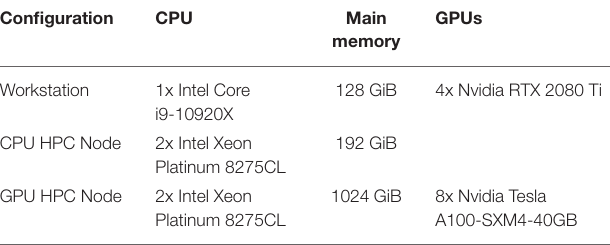
TABLE 1 | Benchmark test hardware configurations.